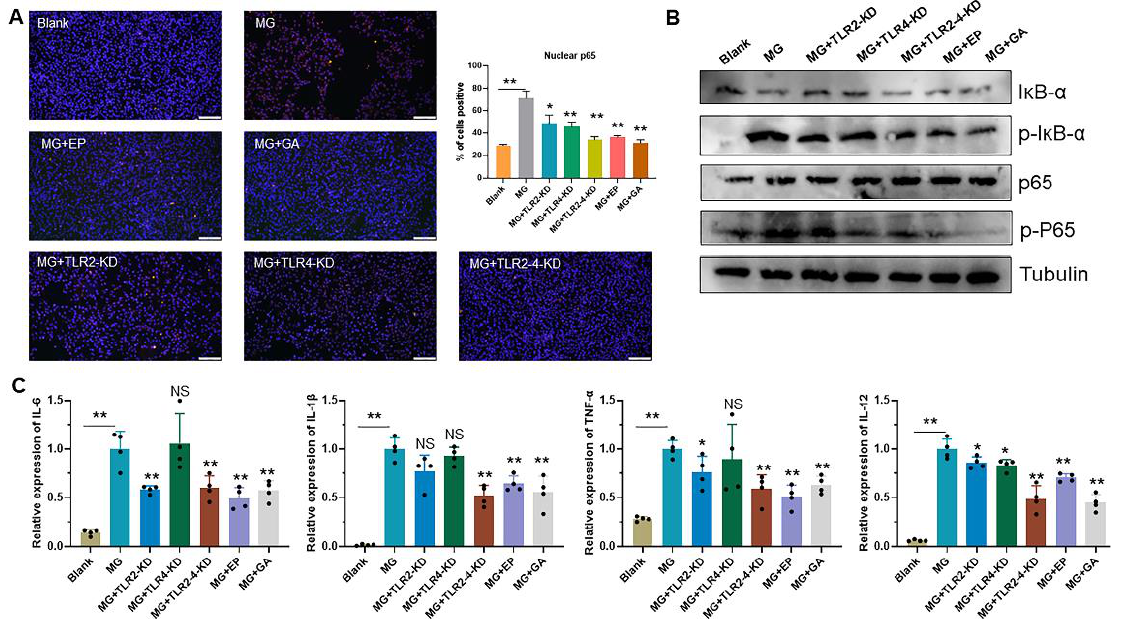
Figure 4. HMGB1 activates the NF- κ B pathway via TLRs. ( A ) Translocation of the NF- κ B p65 subunit from the cytoplasm into the nucleus was assessed by immunofluorescence staining. NF- κ B p65 was stained with red; cell nucleus was stained blue with DAPI (scale bar, 100 µm). ( B ) The protein expression of NF- κB pathway -related genes in different treatment groups were detected by Western blotting. GAPDH was used for normalization. ( C )The relative expression levels of TNF- α, IL - 1β, IL - 12, and IL-6 mRNA in HD-11 cells. NS p > 0.05, * p < 0.05, and ** p < 0.01 show statistically significant difference compared to the MG group. Black dots in bar graph represent datasets from independent experiments.